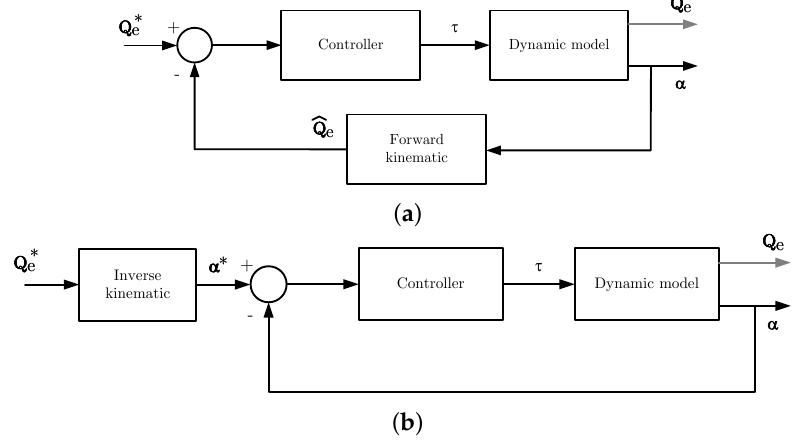
Figure 6. Overall control approaches. ( a ) Cartesian coordinates’ space control; ( b ) joint coordinates’ space